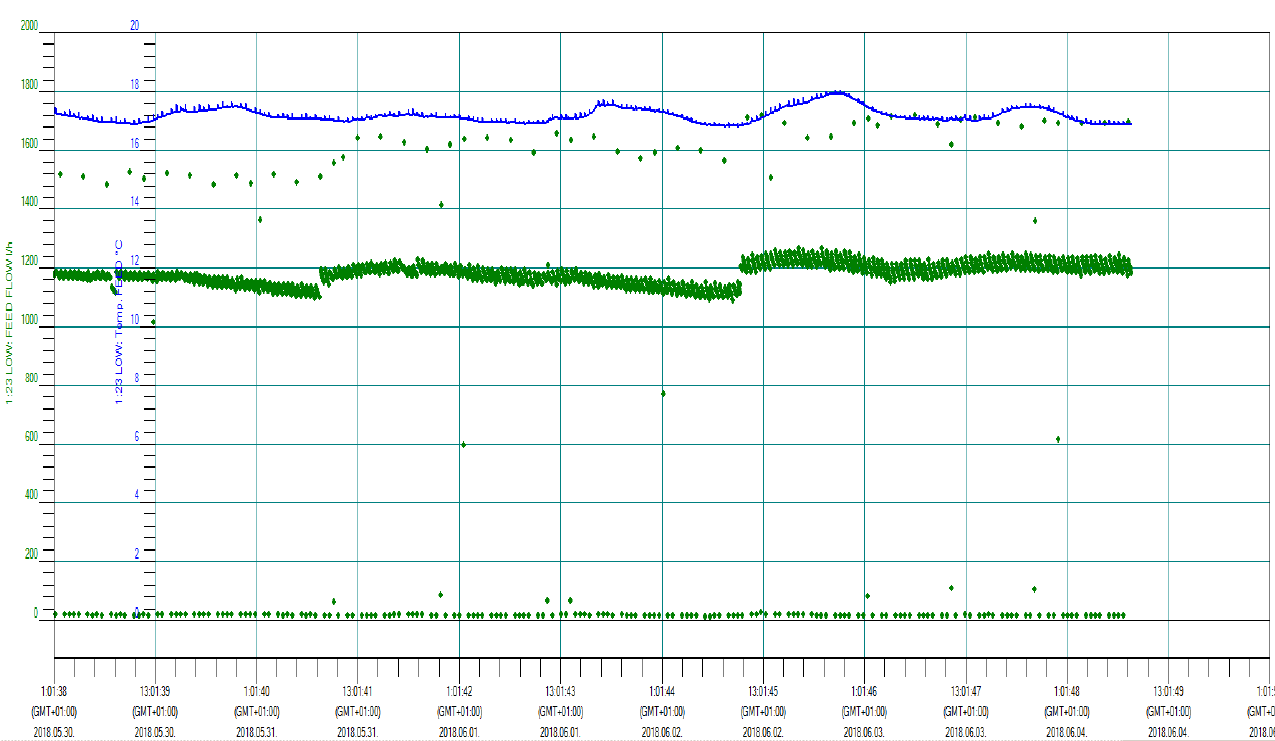
Figure A11. Flow and TMP at 105 L/m 2 h.